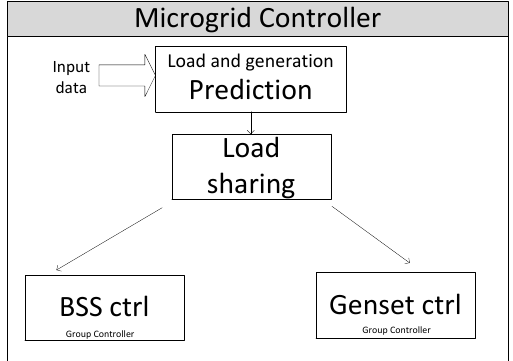
Fig. 3. Structure of the microgrid controller